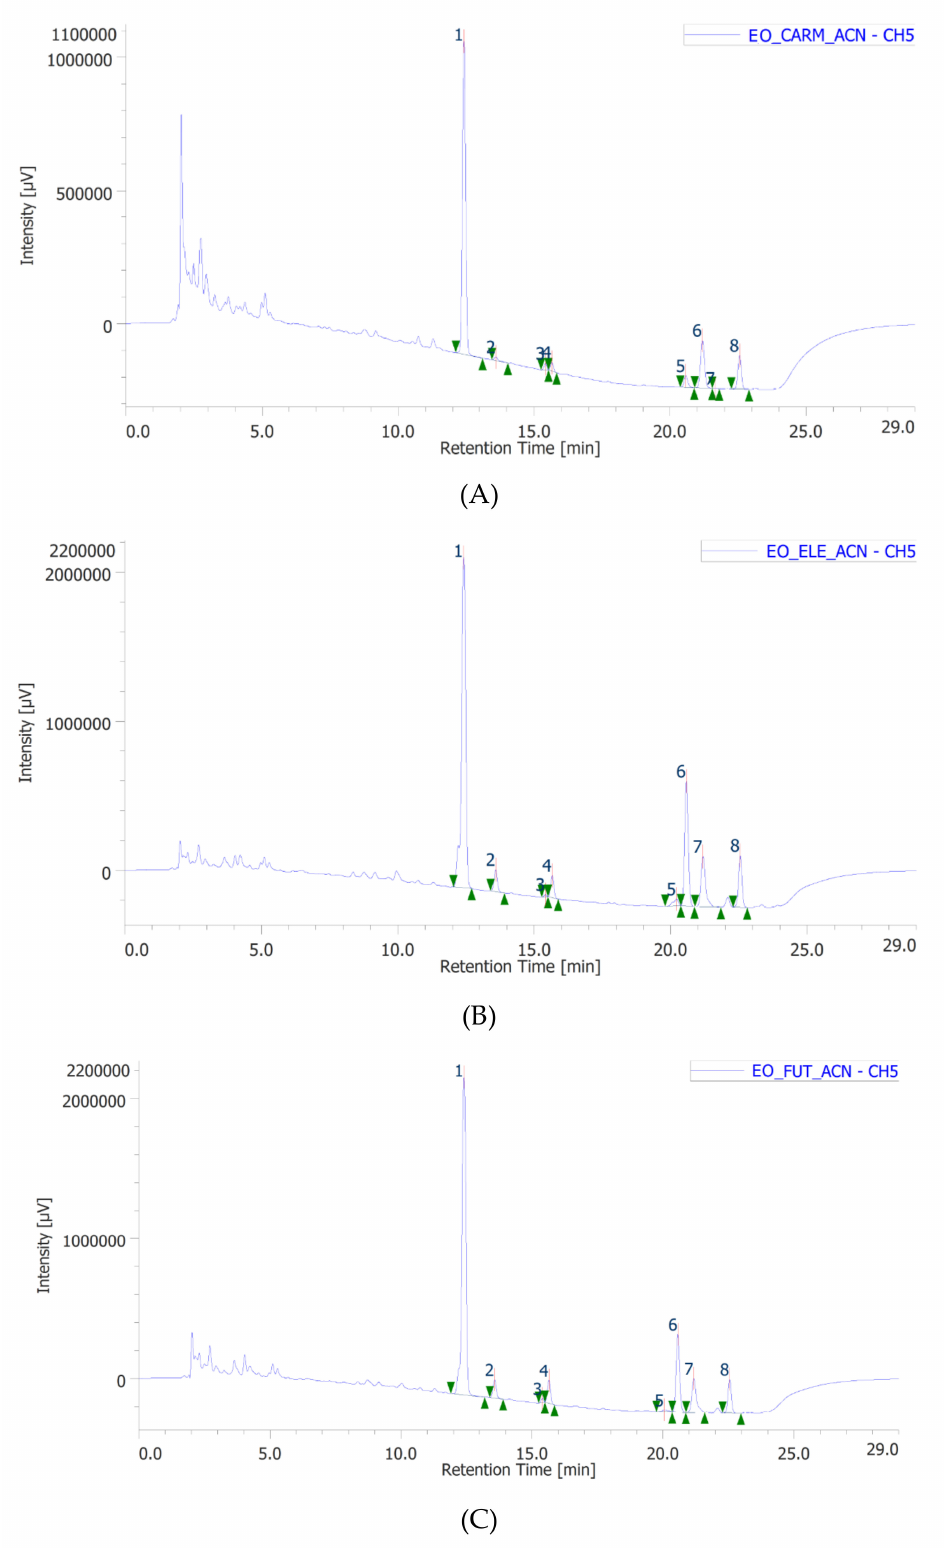
Figure 1. High-performance liquid chromatography coupled to ultraviolet and mass spectrometry detectors (HPLC–UV-MS) analysis of Carmagnola selezionata ( A ) , Eletta campana, ( B ) and Futura 75 ( C ) terpenophenols. In all tested essential oils, cannabidiolic acid (1) was the prominent phytocompound compared to the other identified terpenophenols. Specifically, the cannabidiolic acid was present in the range 57.4–70.6%, corresponding to 24.6–62.9 µ g/mg